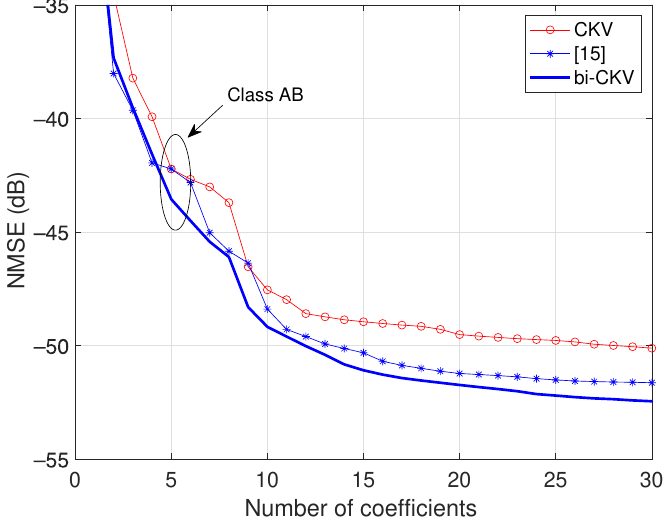
Figure 6. Comparison of NMSE for the bi-CKV model and the results published in [15] applied to a class AB power amplifier operated at 3.6 GHz with an average output power of 27.4